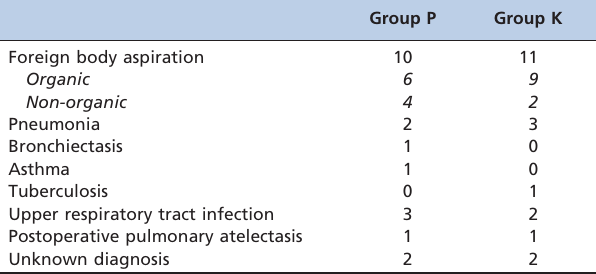
Table 2 - Diagnosis after rigid bronchoscopy.